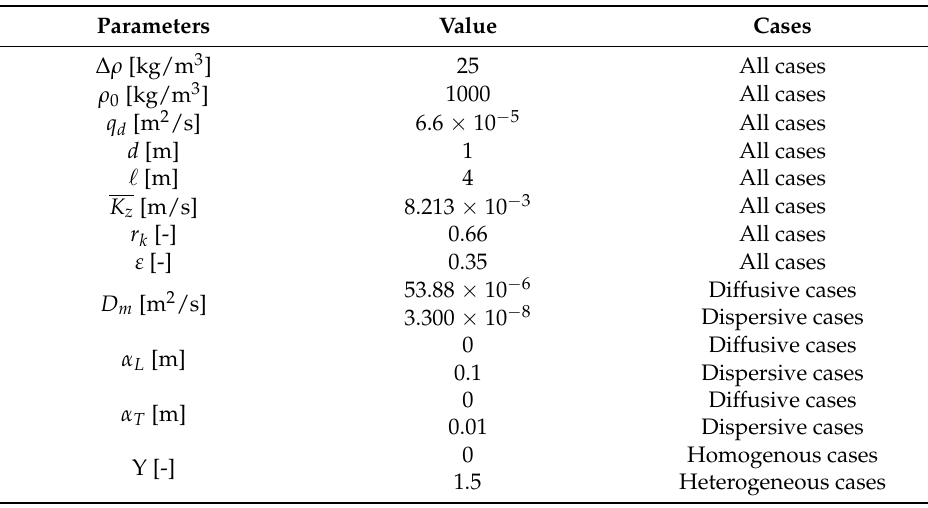
Table 2. Physical parameters used in the numerical model for the verification test cases.